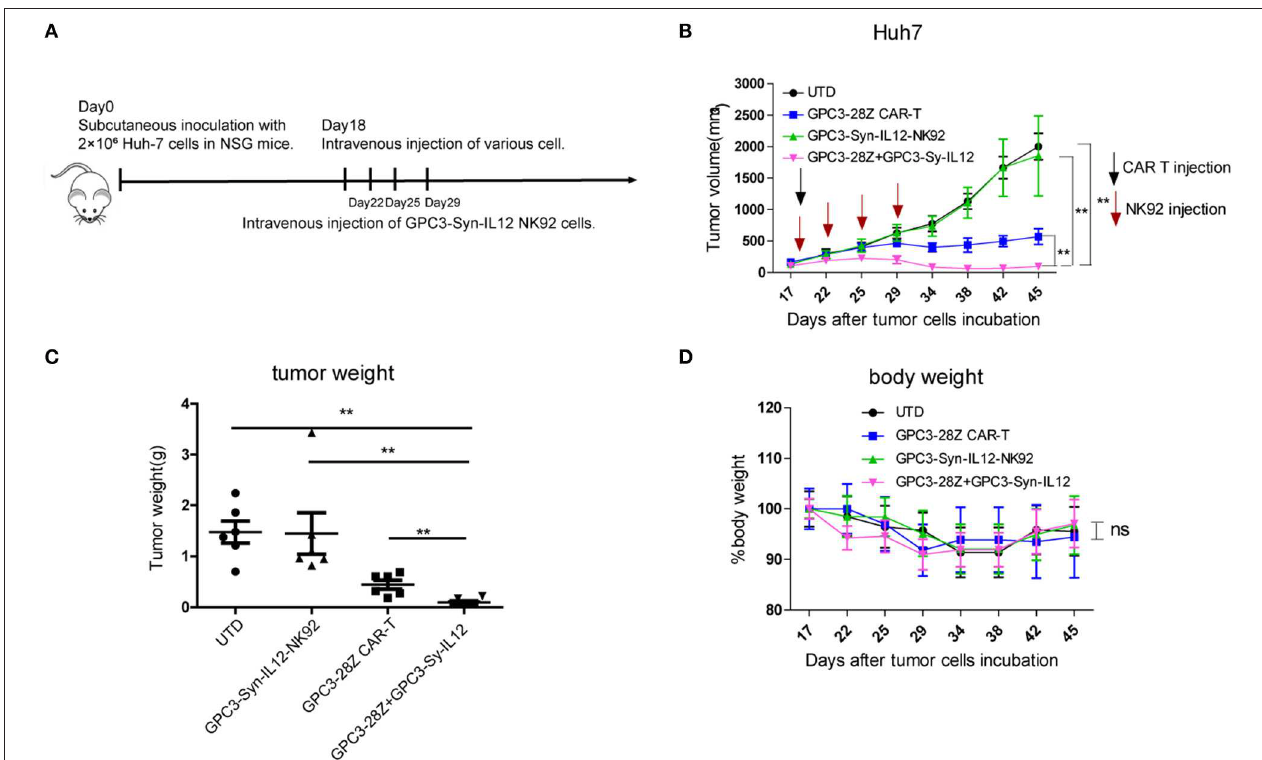
FIGURE 4 | In vivo antitumor activities of GPC3-28Z CAR T cells on established subcutaneous GPC3-positive Huh7 xenografts when combined with GPC3-Syn-IL12 NK92 cells. (A) Experimental scheme of the in vivo antitumor experiment. On day 0, 2 × 10 6 Huh-7 cells were subcutaneously injected into 6-week-old female NSG mice. On day 18, mice bearing tumors of approximately 150 mm 3 were infused intravenously with 1 × 10 6 indicated T cells or NK92 cells. NK92 cells were infused every 2–3 days approximately four times. Each treatment group included 6 mice. (B) Tumor growth curve of treatment with the indicated T cells or NK92 cells. At the endpoint, the residual tumors treated with the combination of GPC3-28Z CAR T cells and GPC3-Syn-IL12 NK92 cells were significantly smaller than those in the other control groups. and tumor volumes were calculated on the basis of V = (length × width 2 ) ÷ 2. (C) Tumor weight at the endpoint of the animal experiment. (D) The body weight of each group was measured every 3–4 days (baseline = 100%). Data are presented as the mean ± SEM. Statistical significance was calculated by two-way analysis of variance (ANOVA). ** P < 0.01. Only significant differences are